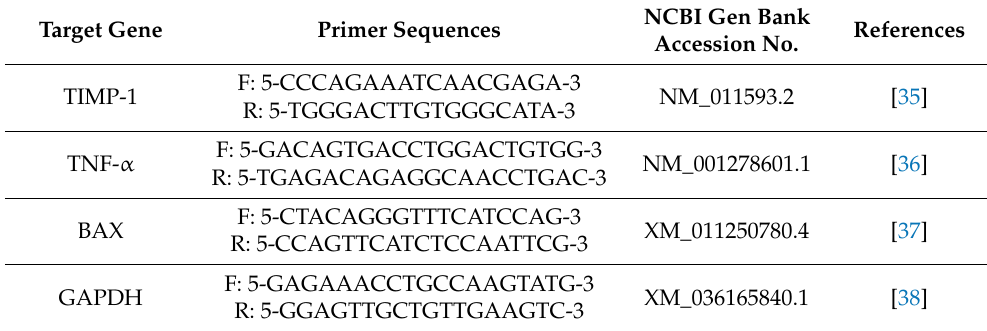
Table 2. Primer sequences used in real-time quantitative PCR reaction. Target